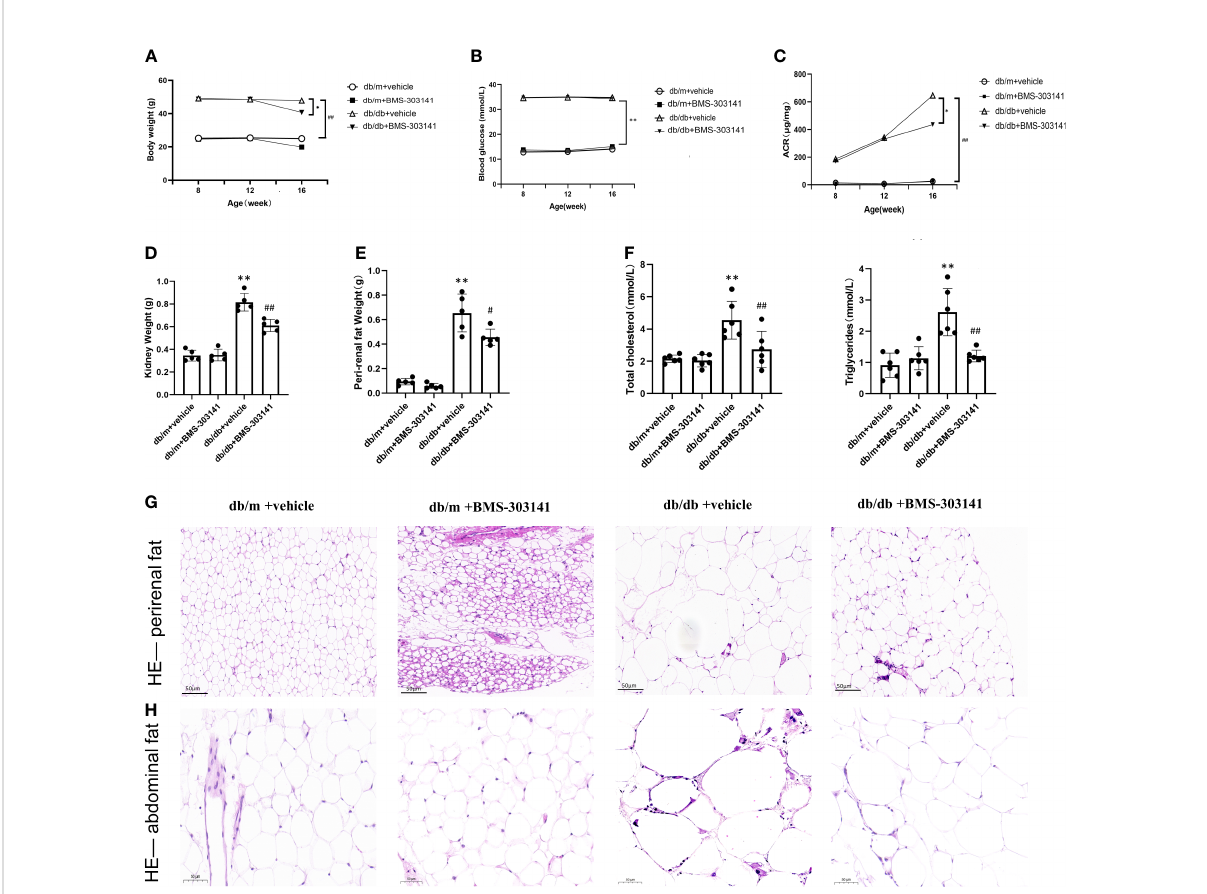
FIGURE 2 Effect of BMS-303141 on systemic metabolic parameters and body fat deposition in db/m and db/db mice. (A) Changes in body weight for 8-week- old db/m and db/db mice, n=8 per each group; (B) Differences in fasting blood glucose, n=8 per each group; (C) Urinary ACR from db/m and db/ db mice for eight weeks, n=8 per each group; (D, E) Kidney and perirenal weight, n=5 per each group; (F) Changes in plasma lipids of eight weeks, total cholesterol and total triglycerides, n=6 per each group; (G, H) H&E staining of perirenal fat and abdominal fat (magni fi cation 200x); Each bar and line represent the mean ± SD of four separate experiments. *P < 0.05, **P < 0.01 versus db/m + vehicle;#P < 0.05, ##P < 0.01 versus db/db + BMS-303141